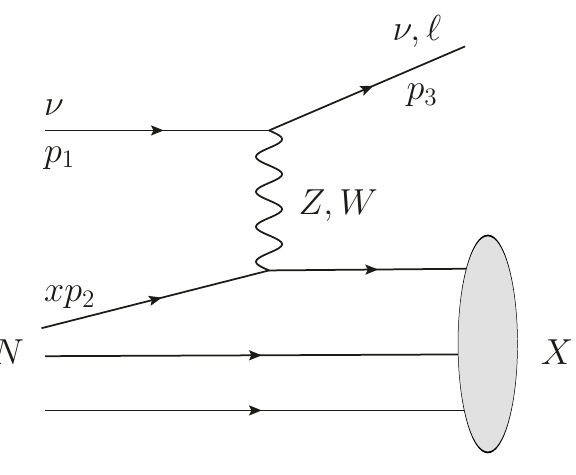
Figure 4 . Kinematics in neutrino Deep Inelastic Scattering